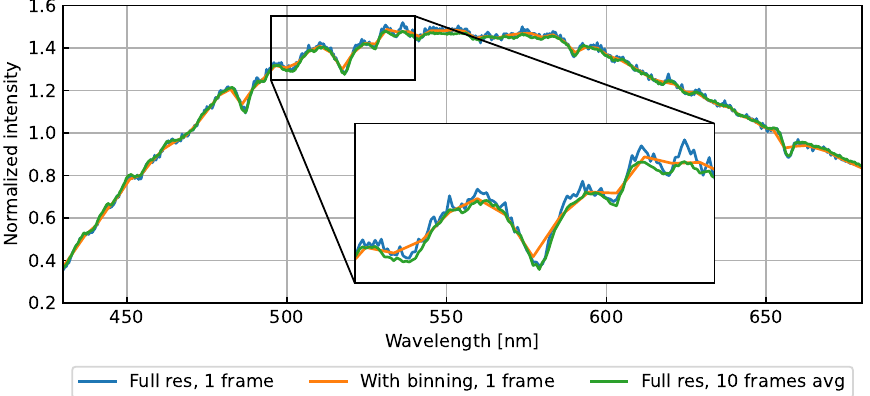
Figure 8. Convolved reference irradiance. Solar irradiance spectrum at 1 nm resolution convolved with a set of instrument responses to obtain simulated solar irradiance spectrum at different spec- tral resolutions.